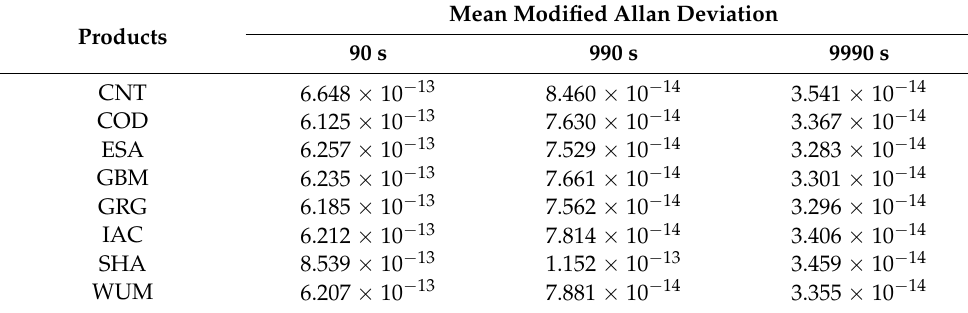
Figure 13. Mean MDEV values for 17 time links derived from Galileo five-frequency PPP with eight different precise products over a week from DOY 248 to 254, 2021. Table 5. Mean MDEV values over all the time links with eight different precise products at an average time of 90, 990, and 9990